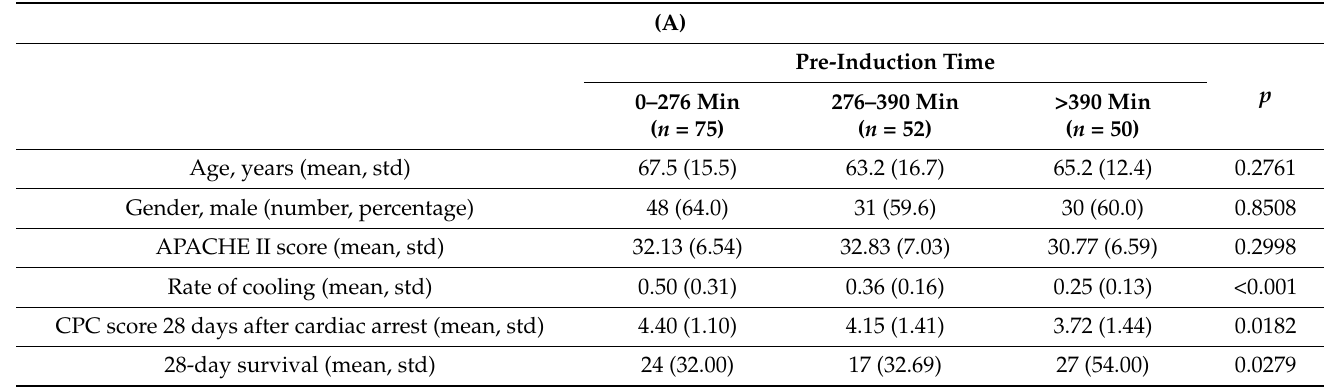
Table 3. ( A ) Comparisons of the three pre-induction time groups. ( B ) Adjusted odds ratios of different pre-induction times for survival and good neurological